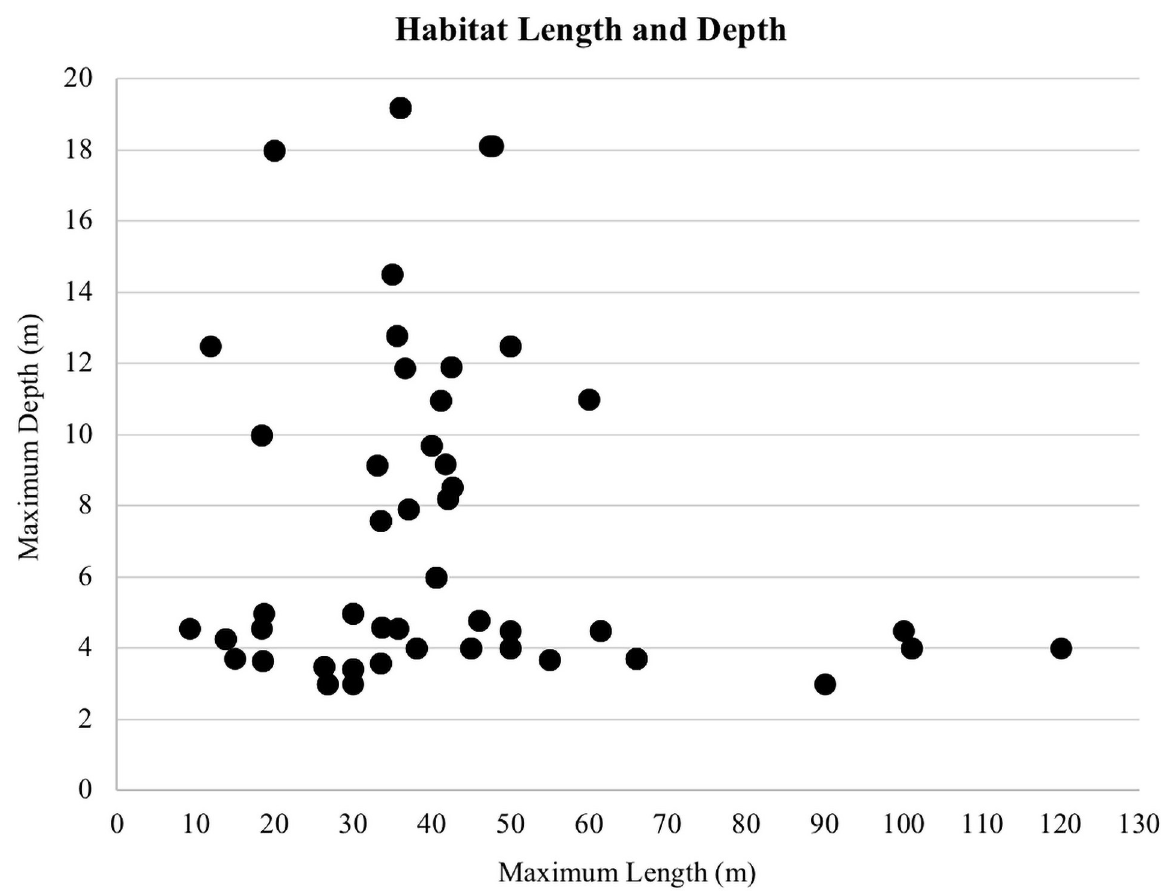
Fig 4. Maximum length plotted against maximum depth for the 40